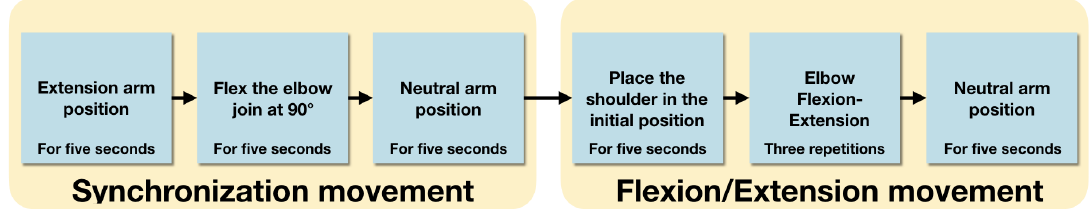
Figure 7. Summary of the protocol’s